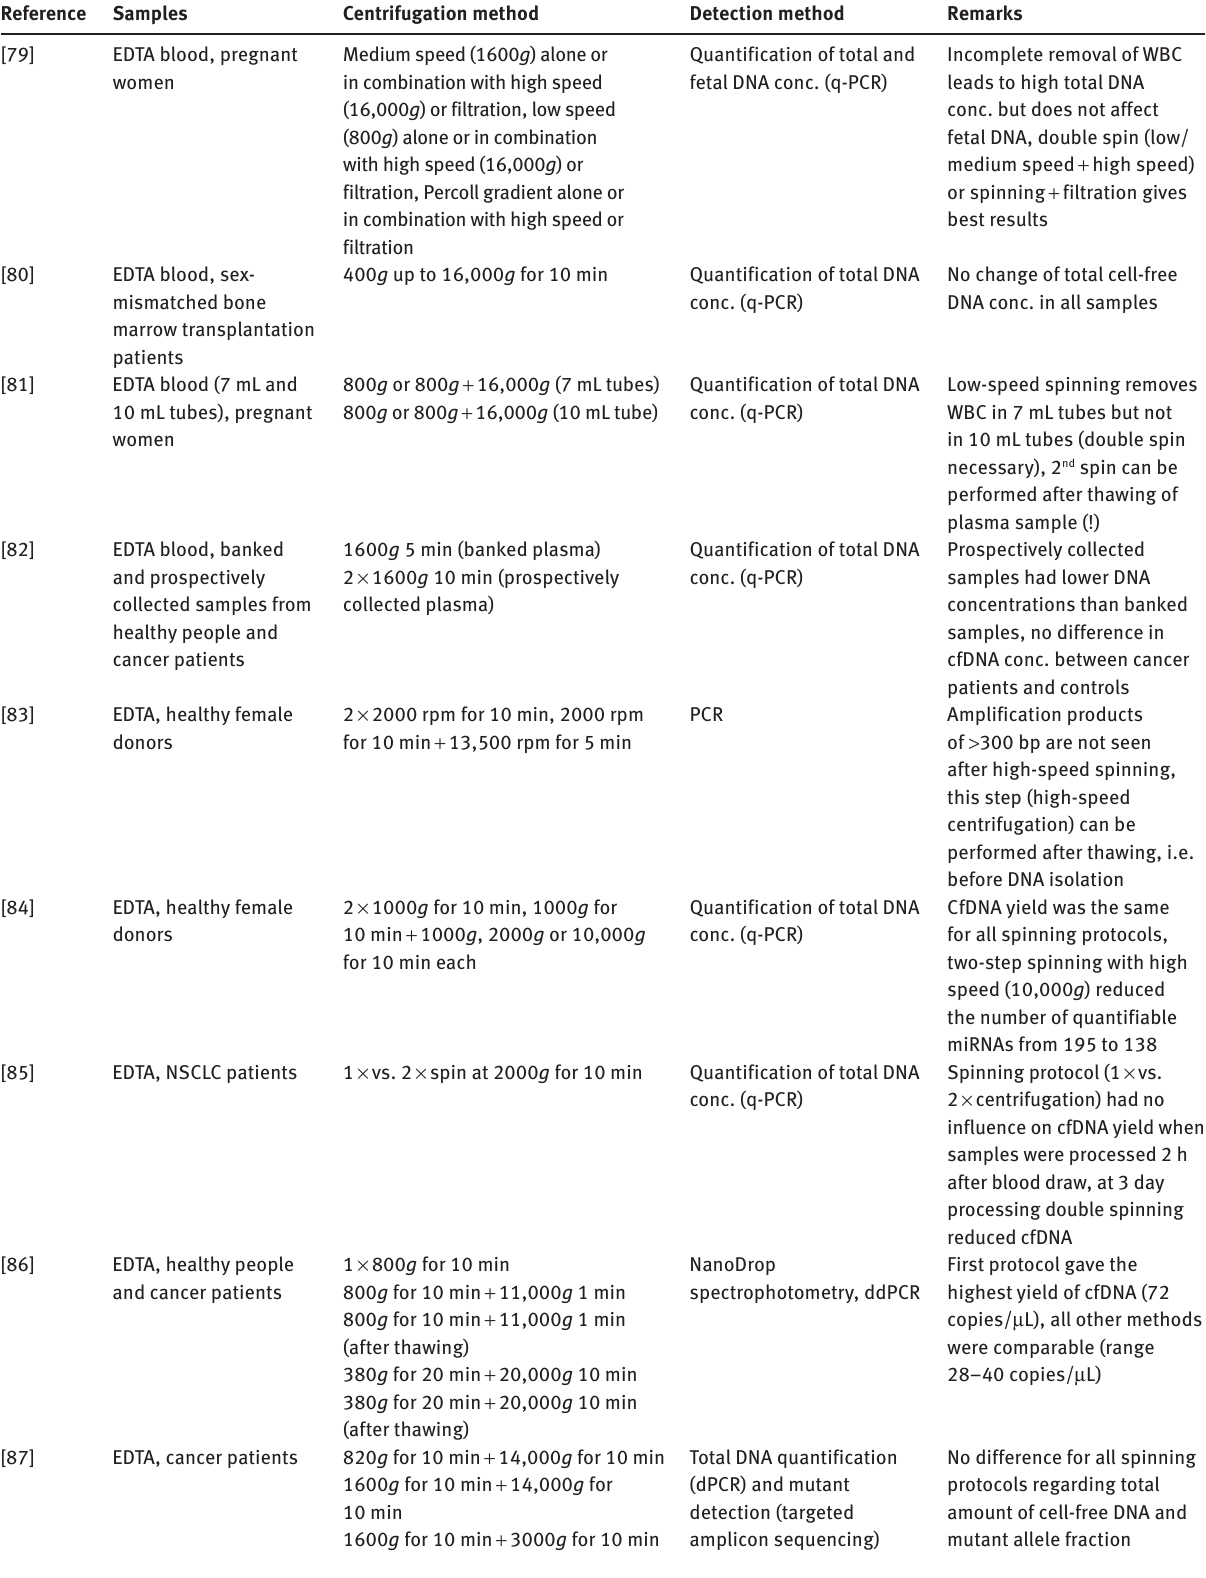
Table 2: Methods for the generation of cell-free plasma.